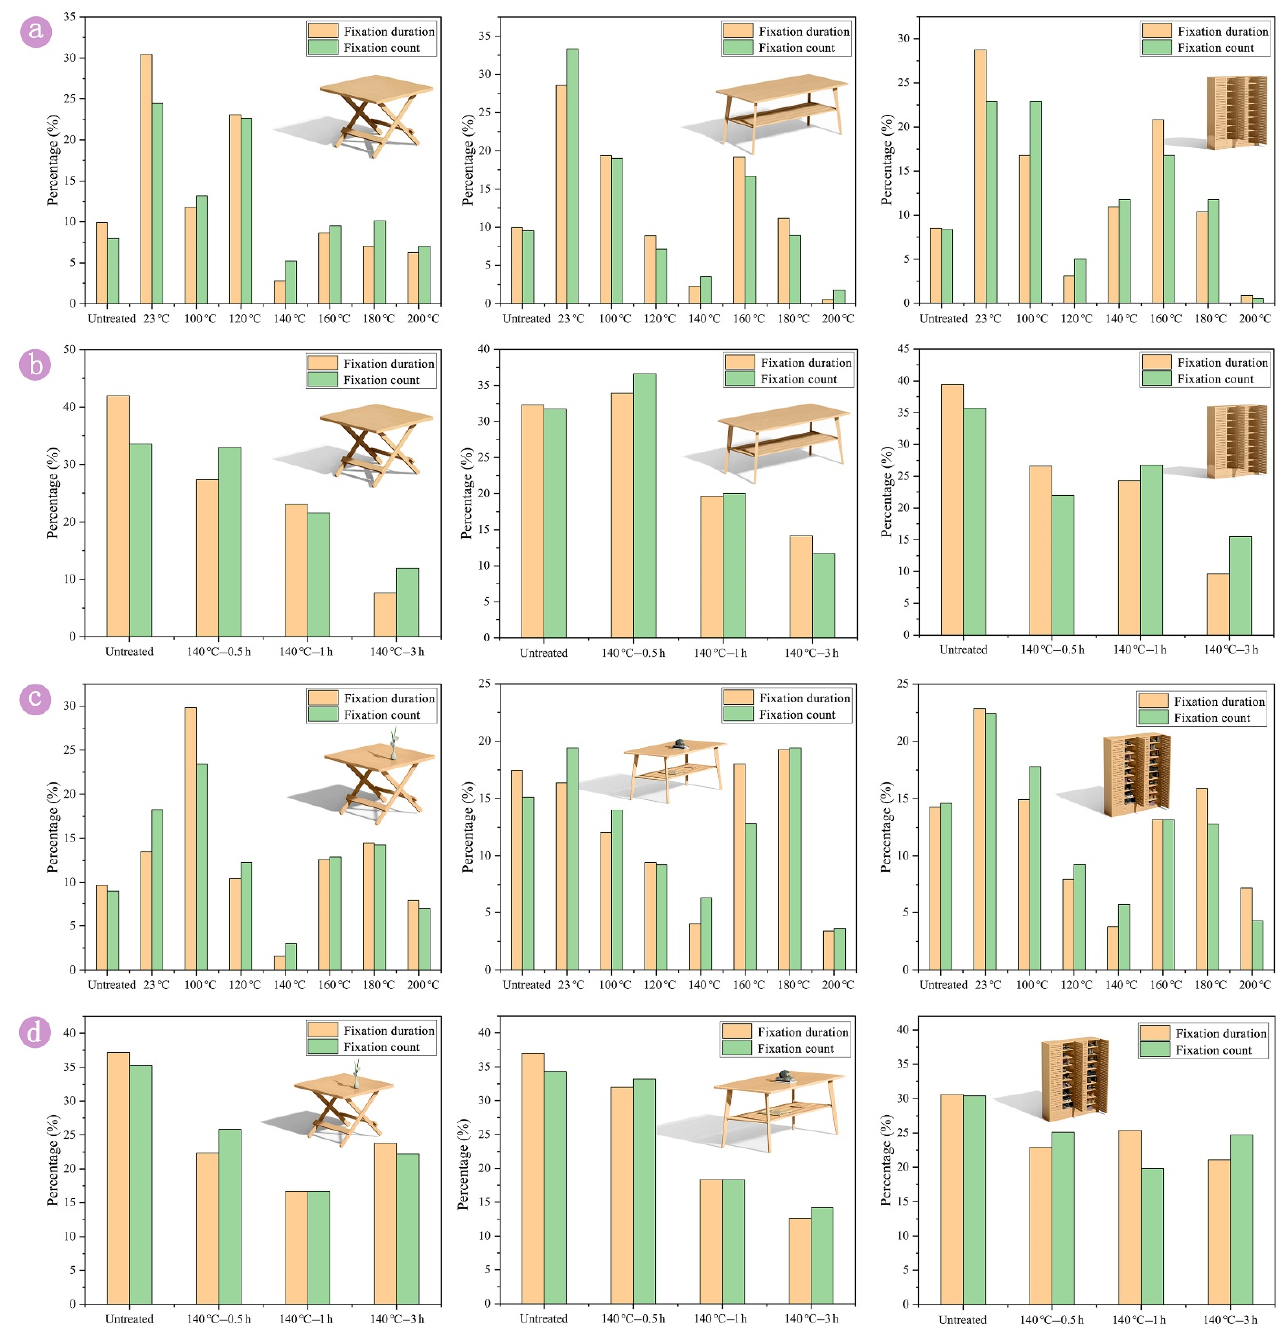
Figure 4. The fix duration and fix count of different bamboo furniture. ( a , b ) Furniture was made of the outer layer of bamboo, ( c , d ) furniture was made of the inner layer of bamboo.